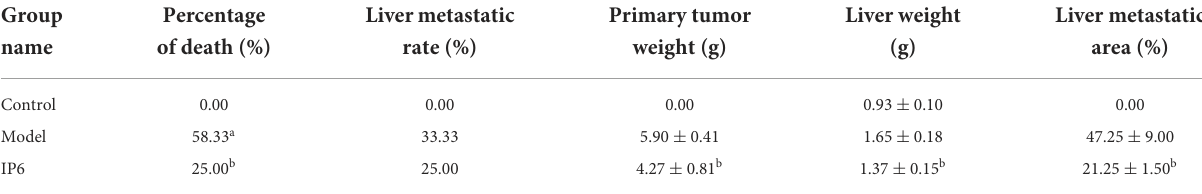
TABLE 1 Effect of IP6 on the progression of colorectal cancer (mean ± SD). Group